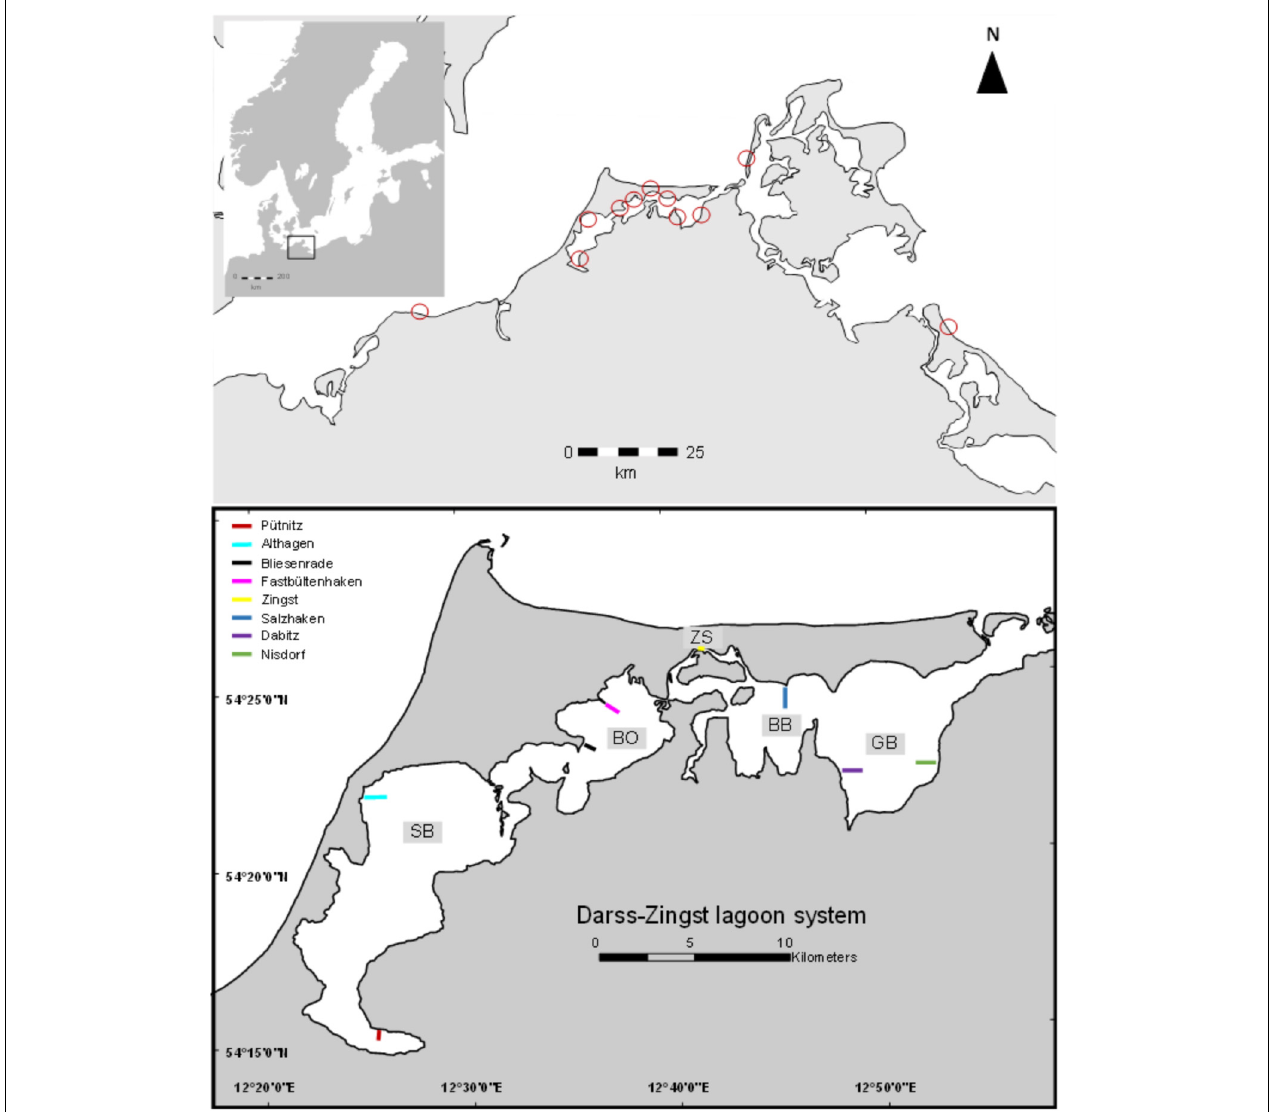
FIGURE 1 | Map of the sampling area (drawn with ArcGIS version 10.2). Colored bars indicate samplings spots of conducted transects. GPS coordinates can be found in the Supplementary Table 1